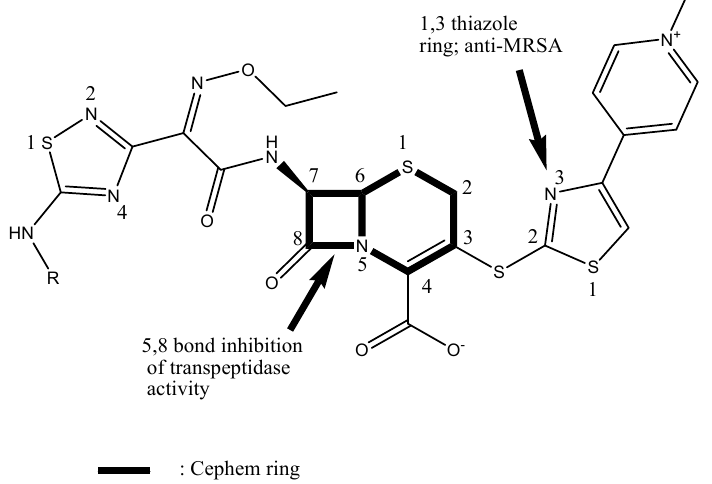
Figure 1. Structure–activity relationships for active ceftaroline (R=H); the prodrug ceftaroline fosamil has the phosphono group at R = − P(=O)(OH) 2